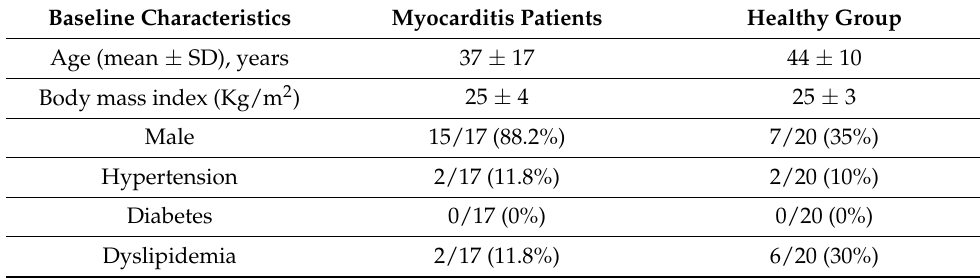
Table 1. Baseline characteristics of the patient study population (n, % unless otherwise